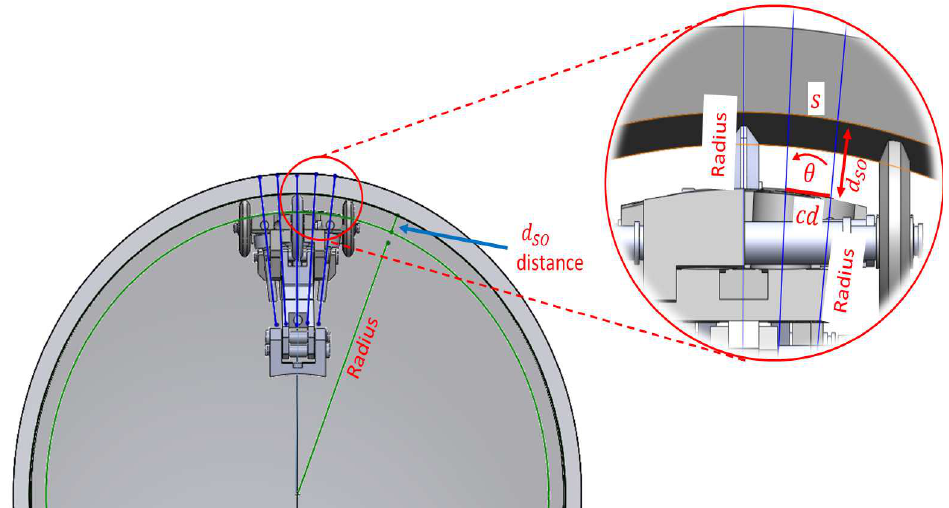
Figure 8. Alignment of holes with the radius of the pipe for mounting the transducers and ensuring the perpendicularity with the inner pipe